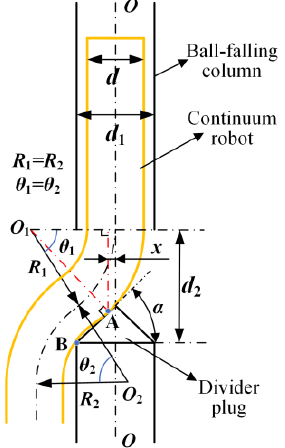
Figure 3. Passive flexible deformation of the robot arm. Points A and B are the intersection points between the continuum robot and the inclined plane of the divider plug, and point A is the tangent point. d and d 1 are the diameters of the ball-falling column and the continuum robot, respectively, and d 2 is the height of the rectangular notch. x is the distance between point A and the center line O – O .